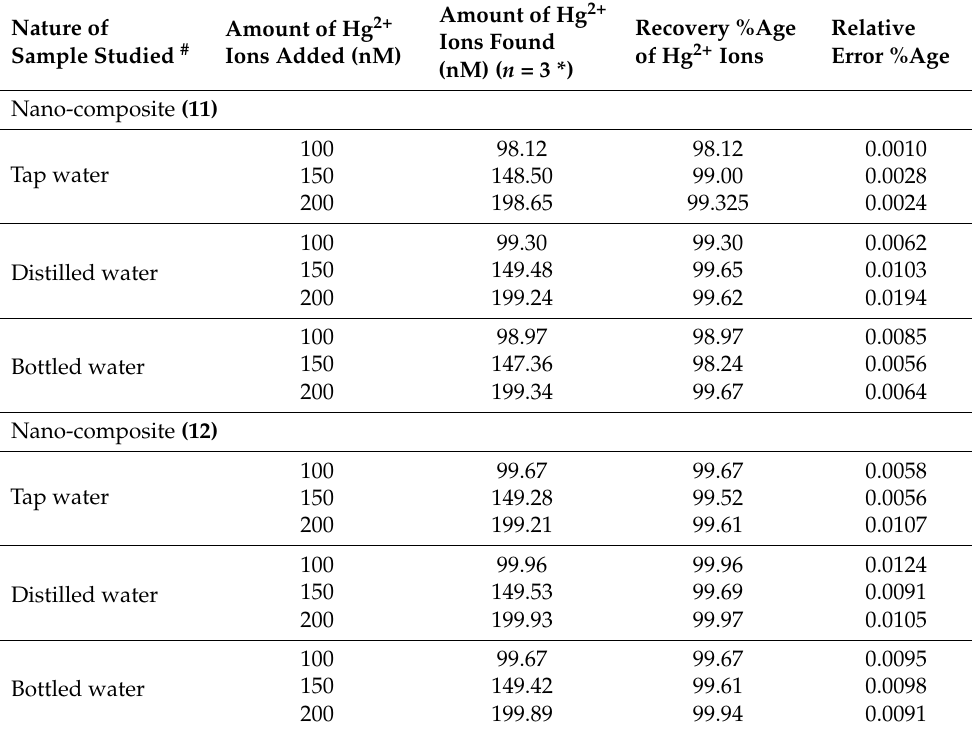
Table 3. Quantitative analysis of an environmental sample with spiked amount of toxic Hg 2+ ions using nano-composites (11) and (12)